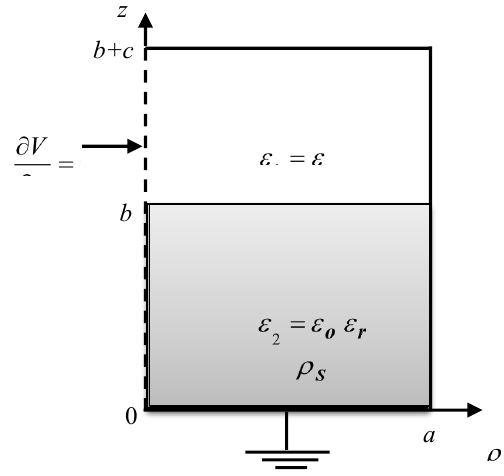
Figure 4. Inhomogeneous Axisymmetric Solution Region.